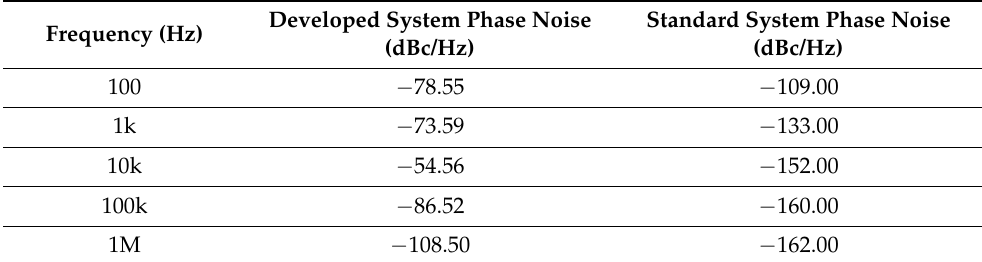
Figure 9. Phase noise plot of the developed measurement system. Table 5. Comparison of the phase noise values of the development measurement system and the standard system NI DAQ 9775 [38].